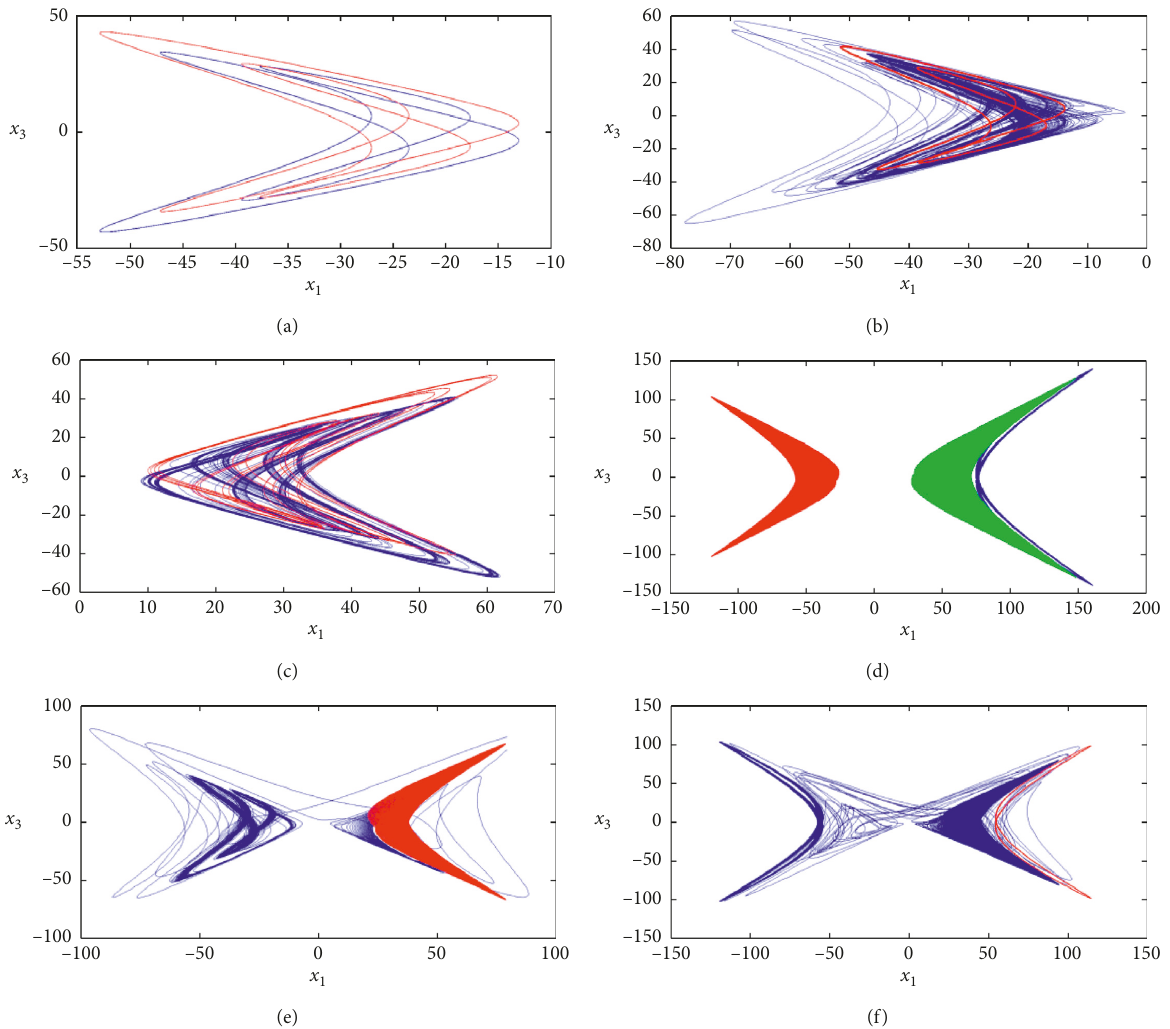
Figure 6: Coexisting multiwing attractors for parameters: (a) d � 9 and the initial conditions are [ 0 . 1 , − 0 . 1 , 0 . 1 , 0 . 1 , 0 . 1 ] and [ 20 , 1 , 1 , 2 , 2 ] (red and blue), (b) d � 8 and the initial conditions are [ 0 . 1 , − 0 . 1 , 0 . 1 , 0 . 1 , 0 . 1 ] and [ 20 , 1 , 1 , 2 , 2 ] (red and blue), (c) d � 12 . 5 and the initial conditions are [ 0 . 1 , − 0 . 1 , 0 . 1 , 0 . 1 , 0 . 1 ] and [ 1 , 0 . 1 , 0 . 1 , 0 . 1 , 0 . 1 ] (red and blue), (d) d � 13 . 5 and the initial conditions are [ 0 . 1 , ± 0 . 1 , 0 . 1 , 0 . 1 , 0 . 1 ] and [ 2 , 1 , 1 , 2 , 2 ] (blue, red, and green), (e) d � 11 . 9 and the initial conditions are [ 0 . 1 , − 0 . 1 , 0 . 1 , 0 . 1 , 0 . 1 ] and [ 2 , 1 , 1 , 2 , 2 ] (red and blue), and (f) d � 13 and the initial conditions are [ 0 . 1 , 1 , 0 . 1 , 0 . 1 , 0 . 1 ] and [ 2 , 1 , 1 , 2 , 2 ] (red and